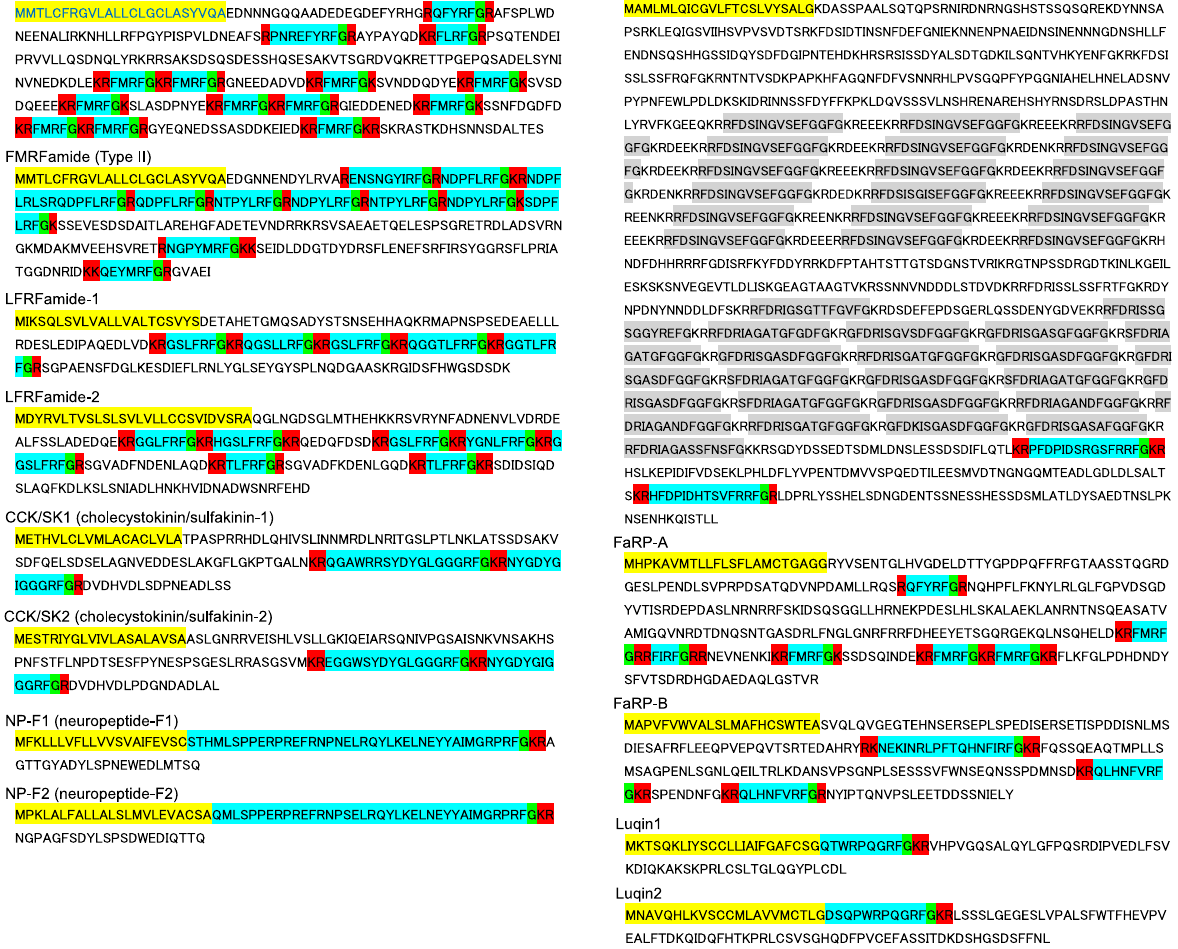
Fig. 1 Predicted amino acid sequences of the precursor proteins encoding RFamide peptides. Only RFamide peptides are indicated, and other non-RFamide peptides are not highlighted (except for PP). Predicted RFamides are highlighted in blue, and predicted signal sequences are highlighted in yellow. Highlighted in red are the basic amino acids predicted to be the cleavage sites. Highlighted in green are the glycine residues used for C-terminal amidation. Highly repeated peptide sequences predicted to be encoded in PP mRNA are highlighted in